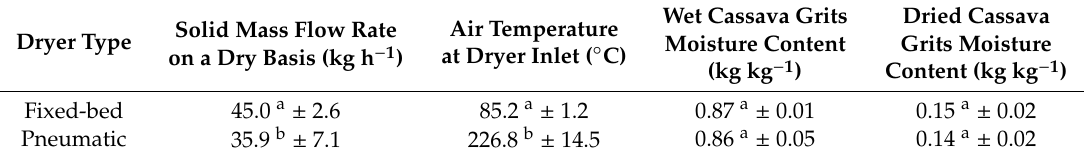
Table 2. Operating conditions of a fixed-bed dryer and of a pneumatic dryer used to process cassava in